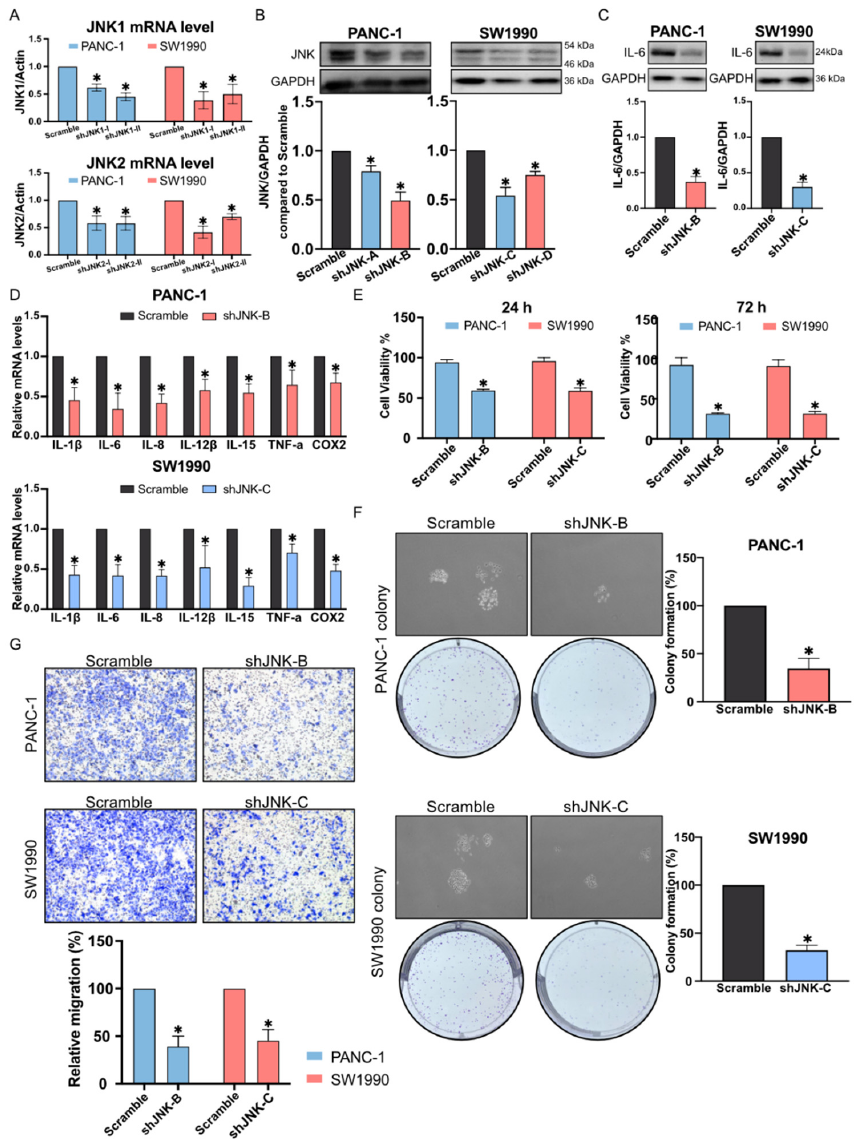
ns = not significantly different, compared with the matching control.